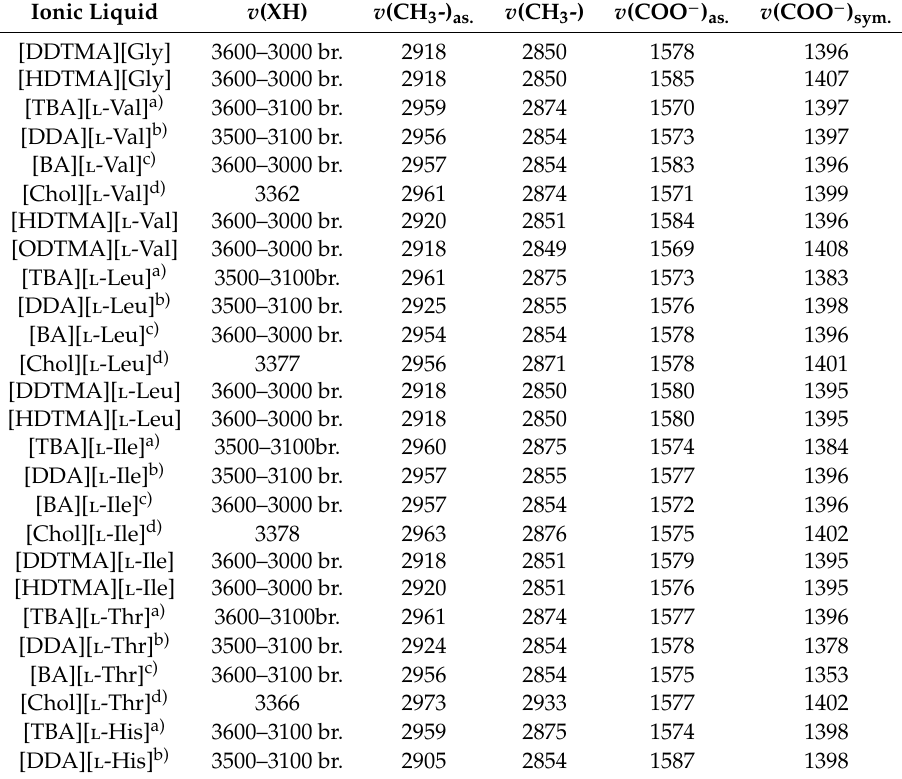
Table 2. Selected infrared (IR) bands of amino acid ionic liquids (cm − 1 ).